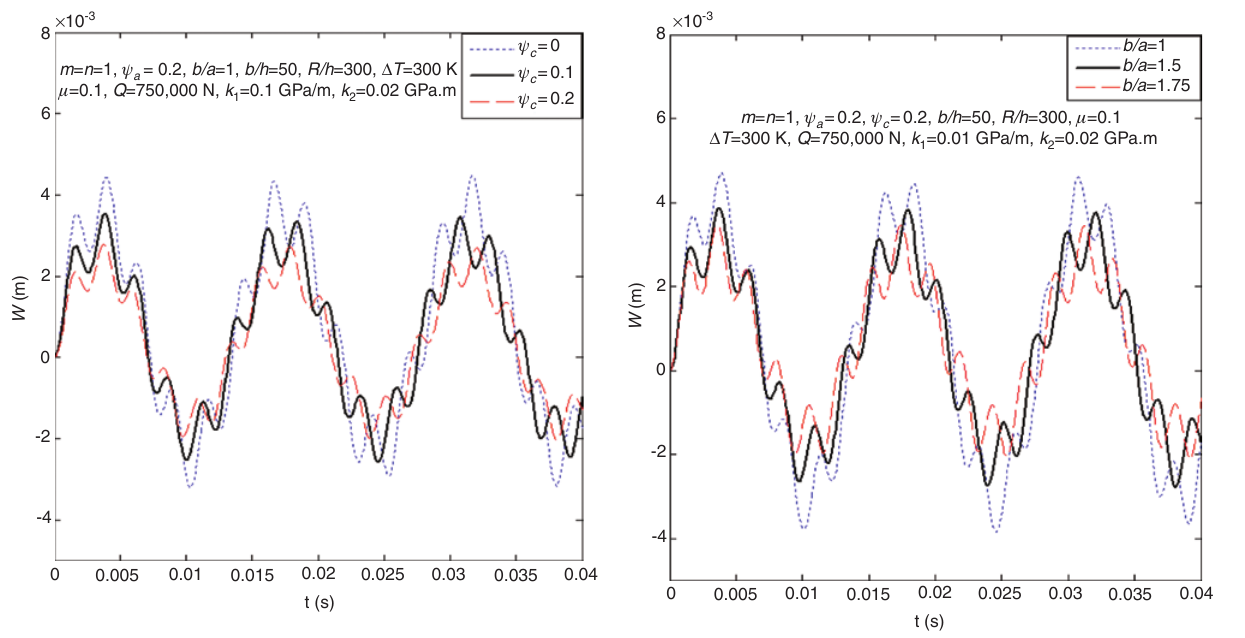
Figure 2: Effects of the particle volume fraction ψ response of the three-phase laminated polymer composite cylindri- cal panel.